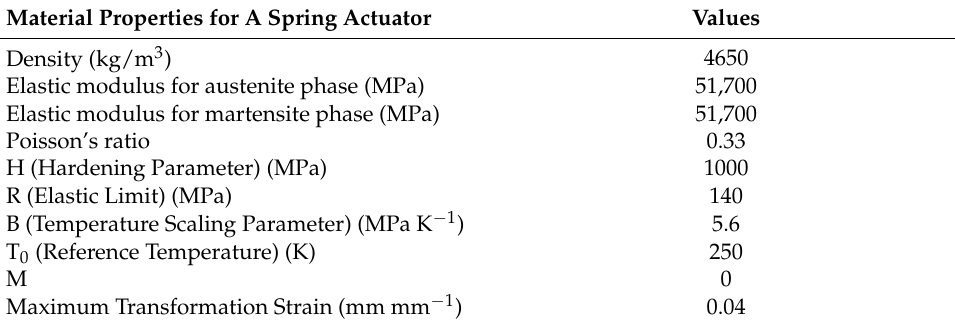
Table 2. Material parameters used for simulation of SMA helical